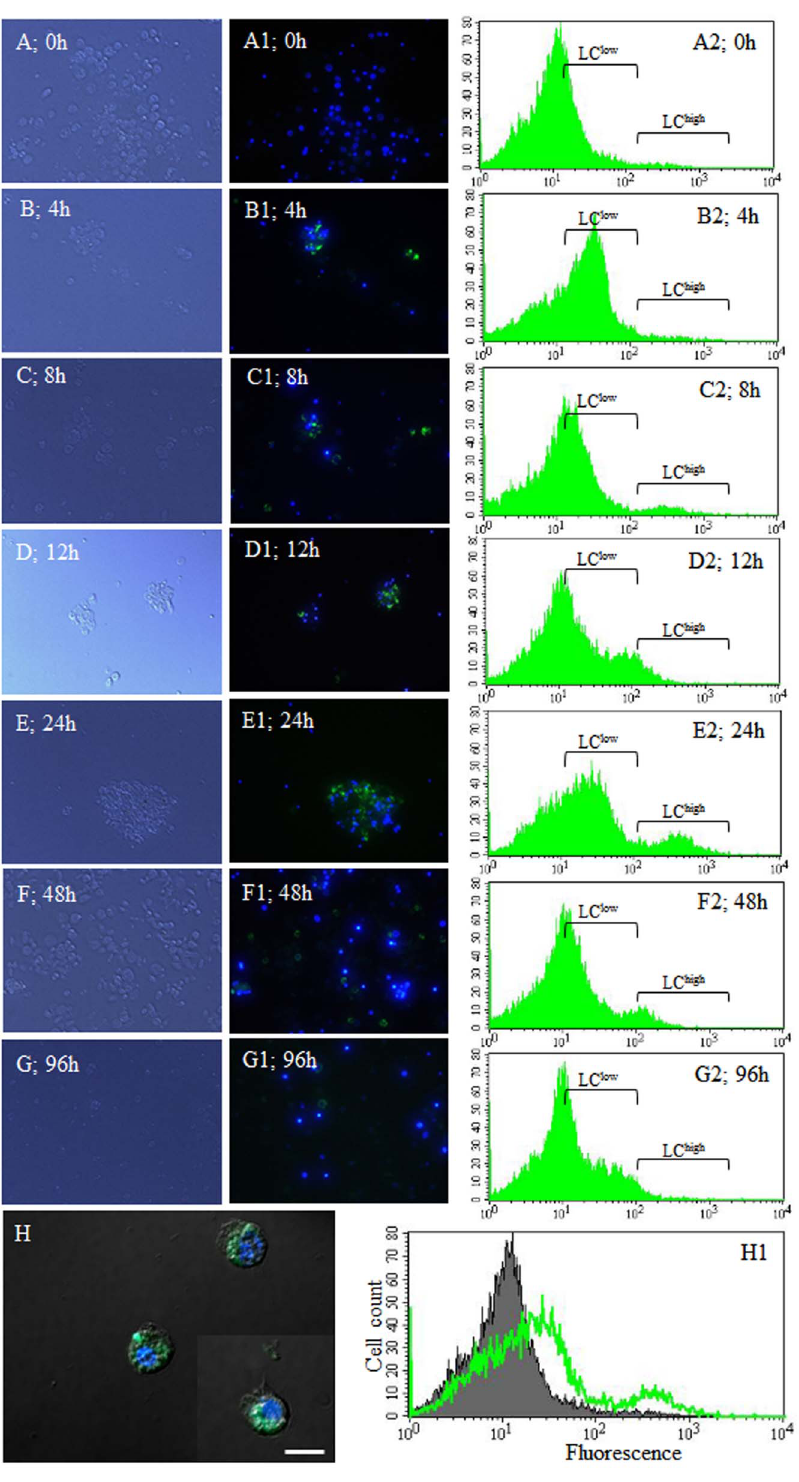
Figure 6. LC3-associated phagocytosis (LAP) by Granulocytes. Non-florescent carboxyl modified beads were injected into the hemocoel. GFP LC3 was used for detection of autophagosome formation in granulocytes at 0–96 h. (A–G) DIC microscope images and fluorescent microscope images (A1–G1) of granulocytes stained with DAPI and GFP-LC3; and flow cytometric analysis (A2–G2). (H) Confocal images of granulocytes stained with DAPI and GFP LC3 at 24 h post injection. (H1) Representative histogram overlay (filled histogram, 0 h post infection, A2; green transparent histogram, 24 h post infection, (E2). Based on the green fluorescence intensity, two peaks were identified, LC low and LC high . (A2 and E2) 11.40% of granulocytes at 24 h post infection and 1.39% of granulocytes at 0 h post infection were in the LC high region, and approximately 10% of GFP-stained hemocytes were increased in the LC low region at 24 h post infection. (F2 and G2) At 48 and 96 h post infection, LC3 accumulation in granulocytes decreased gradually. doi:10.1371/journal.pone.0103620.g006 PLOS ONE |